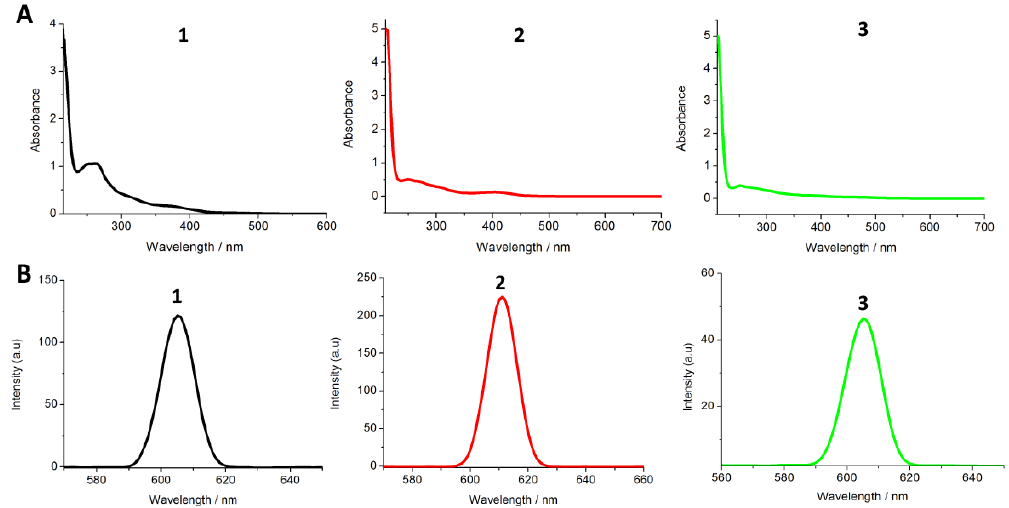
Figure 1. ( A ) UV-Vis and ( B ) luminescence spectra of 10 µM complexes 1 , 2 , and 3 in PBS solution at room temperature.